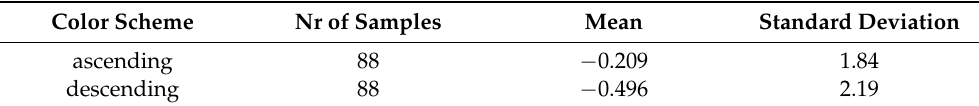
Table 13. Descriptive statistics of error in two maps used in Procedure